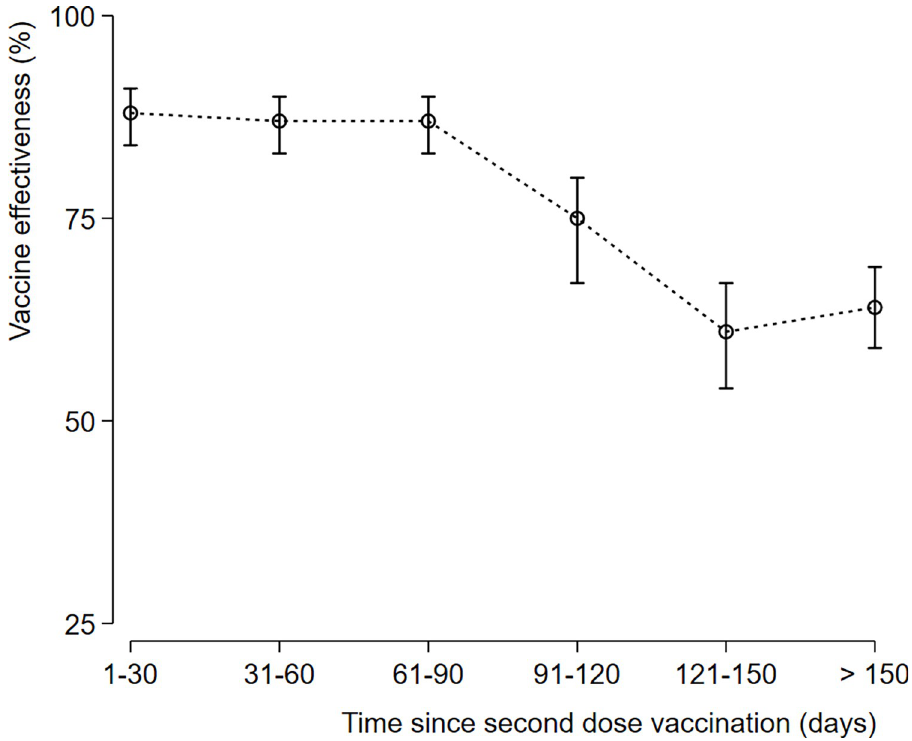
Fig 2. Vaccine Effectiveness of inactivated vaccine BBIBP-CorV against COVID-19-associated severe or critical hospitalization over time since second dose vaccination. Vaccine Effectiveness at each Time Point: At (1–30) time point; VE 88% (95% CI: 84–91), At (31–60) time point; 87% (95% CI: 83–90), At (61–90) time point; 87% (95% CI: 83– 90), At (91–120) time point; 75% (95% CI: 67–80), At (121–150) time point; 61% (95% CI: 54–67), Beyond 150 days’ time point; 64% (95% CI: